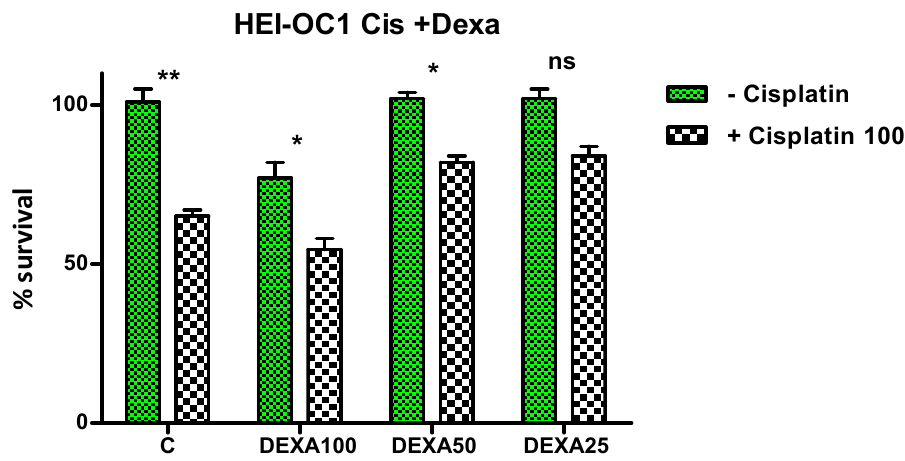
Figure 8. Protection of HEI-OC1 cells by pretreatment with Dexamethasone. Two-way ANOVA, Bonferroni post-tests. (** p < 0.01; * p < 0.5)